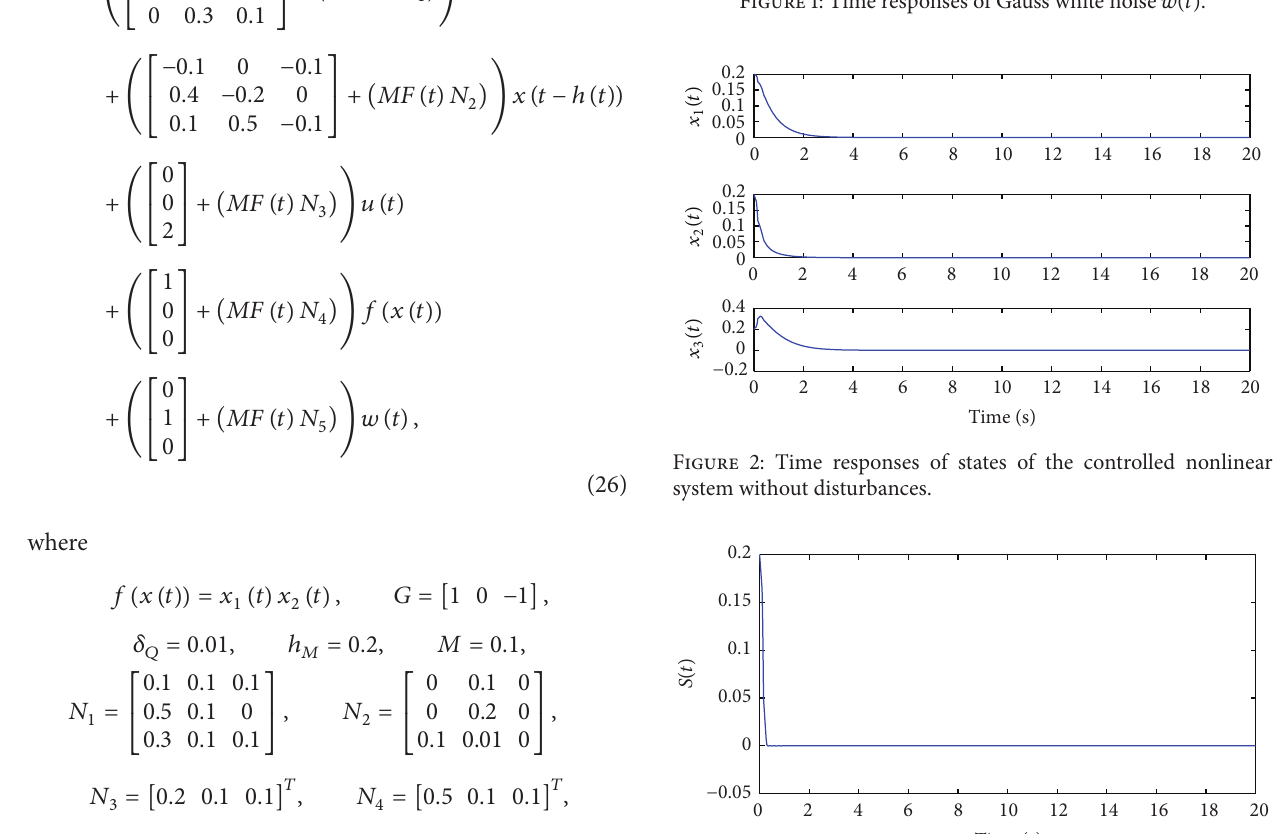
Figure 1: Time responses of Gauss white noise 𝑤(𝑡) .